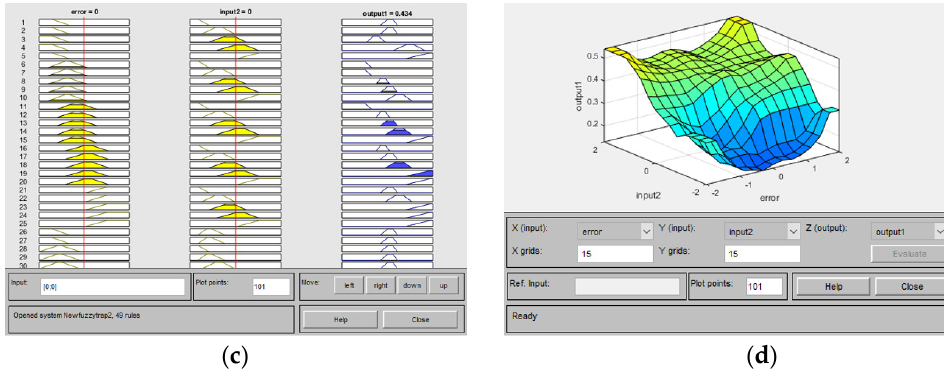
Figure 6. Triangular MF—( a ) Rule viewer ( b ) Surface viewer; Trapezoidal MF—( c ) Rule viewer ( d ) Surface viewer.